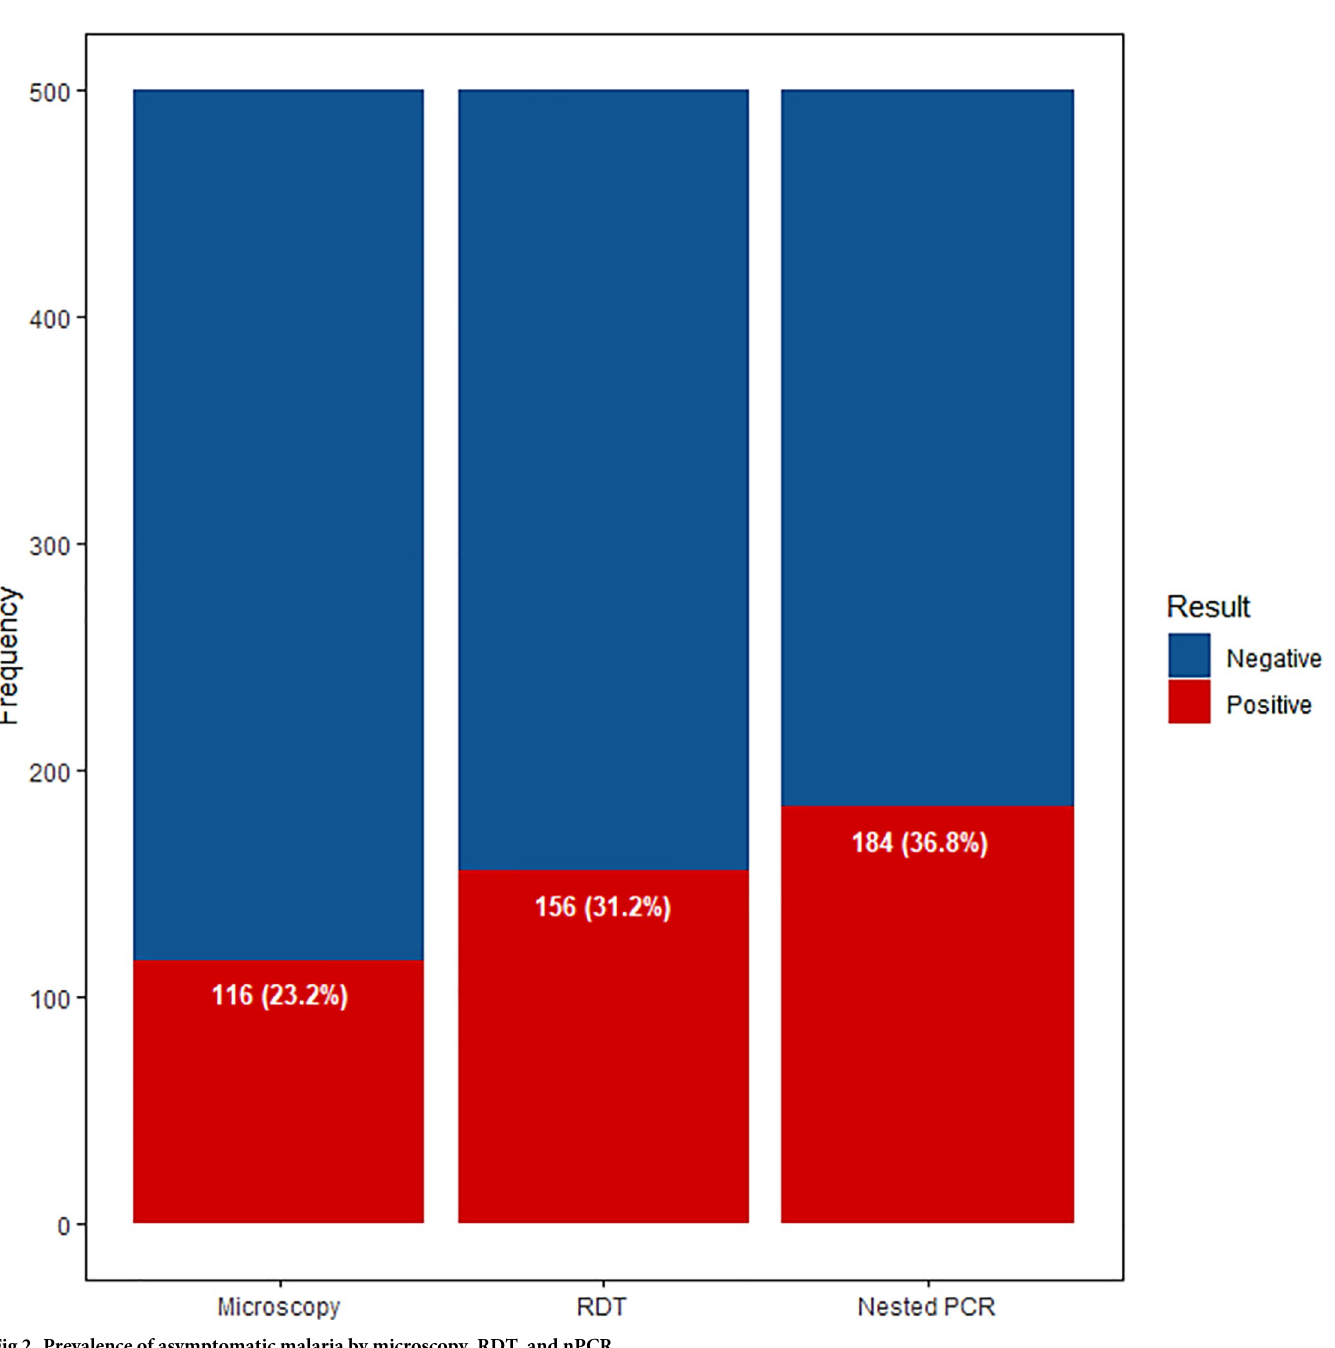
Fig 2. Prevalence of asymptomatic malaria by microscopy, RDT, and